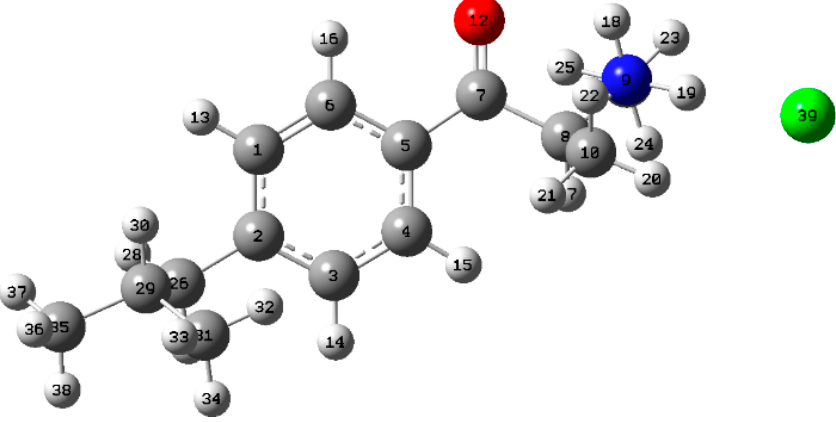
Figure 4. The structure of the most stable conformer of ( S )-4-isobutylmethcathinone hydrochloride in MeOH simulated at B3LYP/6-311++G(d,p)/CPCM level. The mirror-image experimental VCD spectra (Figure 5 bottom, blue and red spectra) confirmed that the two separated molecules were individual enantiomers of 4-isobutylcathinone. After a comparison of the spectral pattern of experimental spectra with the simulated VCD spectrum of ( S )-enantiomer (Figure 5, top), the absolute configuration of the enantioseparated samples was assigned as ( S )-4-isobutylcathinone for the blue spectrum (Figure 5, bottom) and ( R )-enantiomer for the red spectrum due to the relative magnitudes and signs of the corresponding VCD bands. To see the corresponding experimental and simulated IR absorption spectra, see ESI (Figure S10).